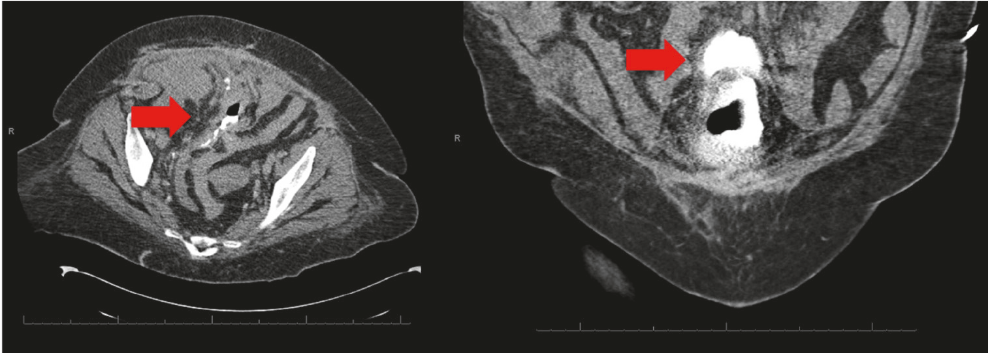
Figure 3: Contrast extravasation demonstrated with computed tomography cystogram